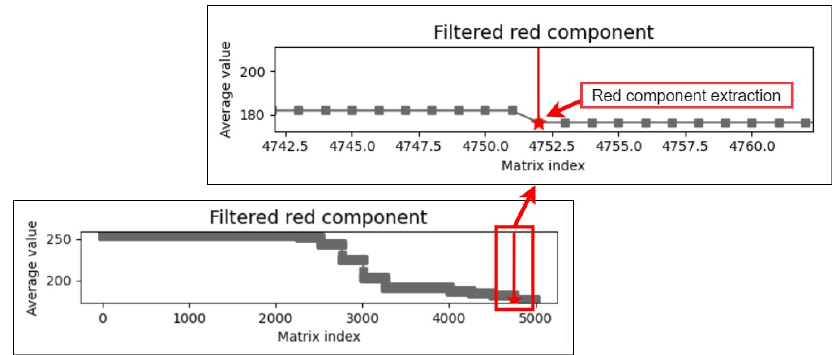
Figure 21. Upper limit extracted for the red component.